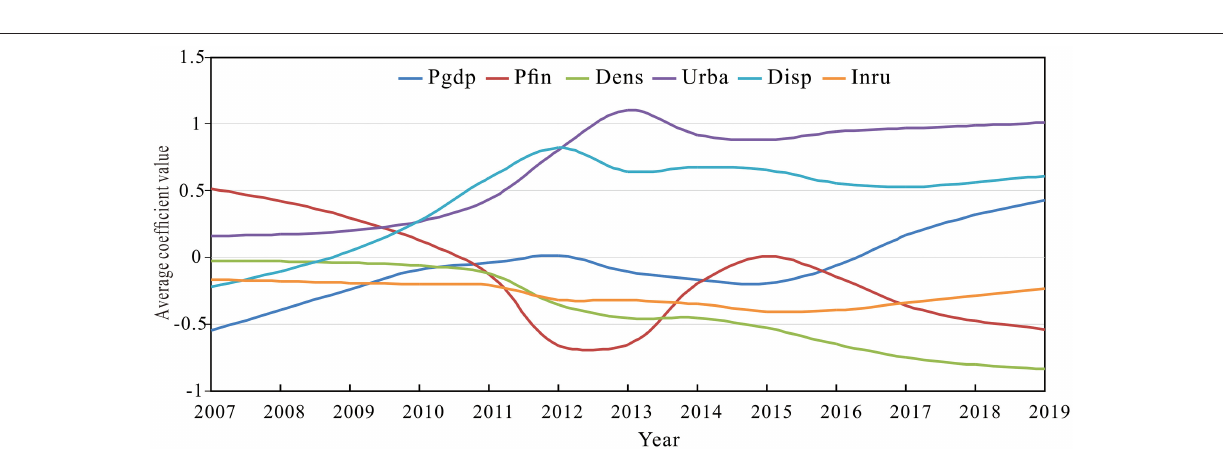
FIGURE 5 | Spatial evolution characteristics of healthcare service supply levels in (A) relative length and (B) curvature.